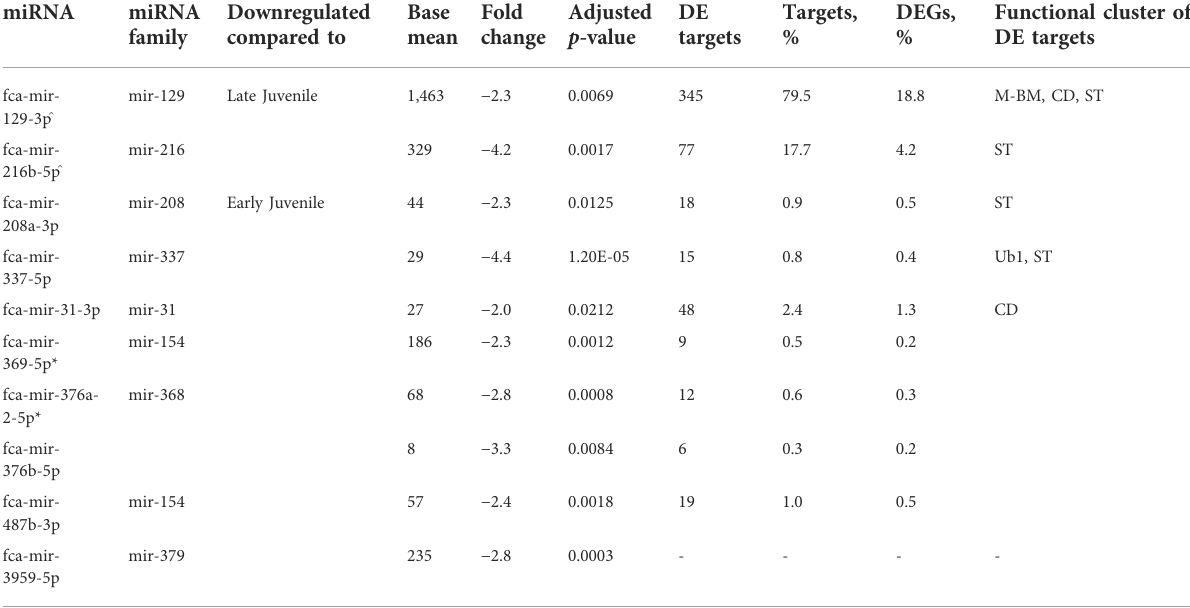
(Figure 6A; Supplementary Tables S3.2 – 5) and vitri fi cation (Figure 6B; Supplementary Tables S3.6 – 7). Both networks can be viewed interactively using fi les in Supplementary Data Sheet S3. Figure 6A shows that miRNA fca-mir-182-5p plays the biggest role in inhibiting mRNAs in response to both 5- and 10-min dehydration protocols. No upregulated miRNAs are shared between ovarian and testicular tissue response to vitri fi cation, but majority of miRNAs inhibit the same two mRNAs, NFAT5 (nuclear factor of activated T-cells 5) and ITGB8 (integrin subunit beta 8), in both gonads (Figure 6B; Supplementary Tables S3.6 – 7). Additionally, NFAT5 is also inhibited by upregulated miRNAs in response to 10 min dehydration (Figure 6B). Functional enrichment analysis of downregulated mRNA targets predicted that 10 min dehydration inhibit processes of ATP binding, transcription regulation, focal adhesion and PI3K- Akt signaling pathways via miRNAs fca-mir-183-5p and fca-mir- 182-5p (Figure 7A). Processes of transcription regulation and zinc ion binding are already inhibited after 5 min dehydration via fca-mir-182-5p (Figure 7B). Vitri fi cation of ovarian tissues was also predicted to inhibit processes of focal adhesion and PI3K- Akt signaling pathway, but via different miRNAs than dehydration protocols (Figure 7B). Vitri fi cation of testicular tissues was predicted to inhibit only nucleic acid binding via one miRNA (Figure 7B). Table 3 presents a summary of all miRNAs upregulated in response to dehydration or vitri fi